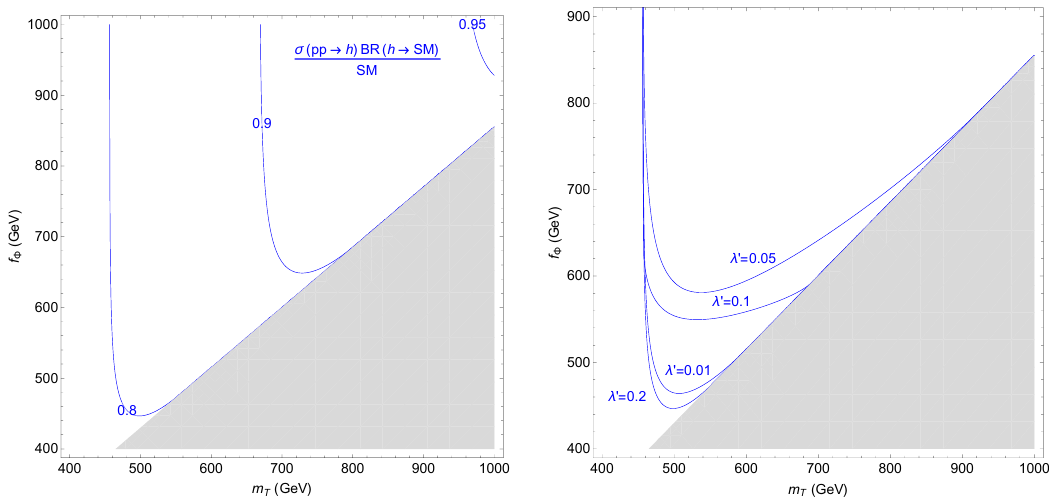
Figure 3 . Left: plot of the ratio of Higgs production to SM (cid:12)nal states in the twin Higgs including (cid:26) for m (cid:26) = f (cid:8) . The (cid:8) A couplings to SM (cid:12)elds have been set to zero. Right: plot of the ratio of Higgs production to SM (cid:12)nal states equal to 0.8 in the twin Higgs including (cid:26) for m (cid:26) = f (cid:8) for several values of (cid:21) 0